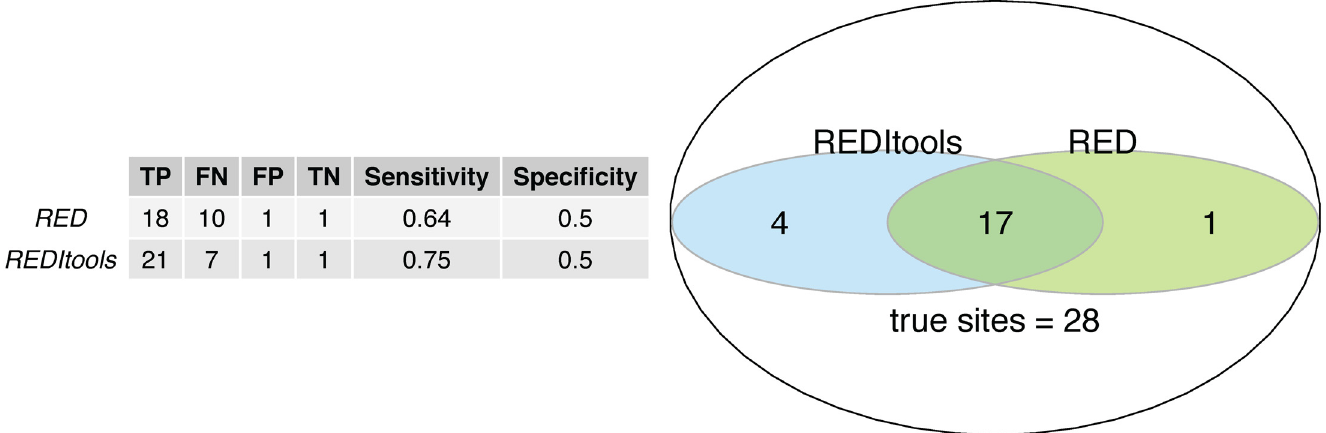
Fig 3. A comparison of validation for identifying RNA-editing sties using RED and REDItools in an analysis of a sample data-set with 28 experimentally validated C ! U RNA editing sites. TP, true positive; FP, false positive; TN, true negative; and FN, false negative.